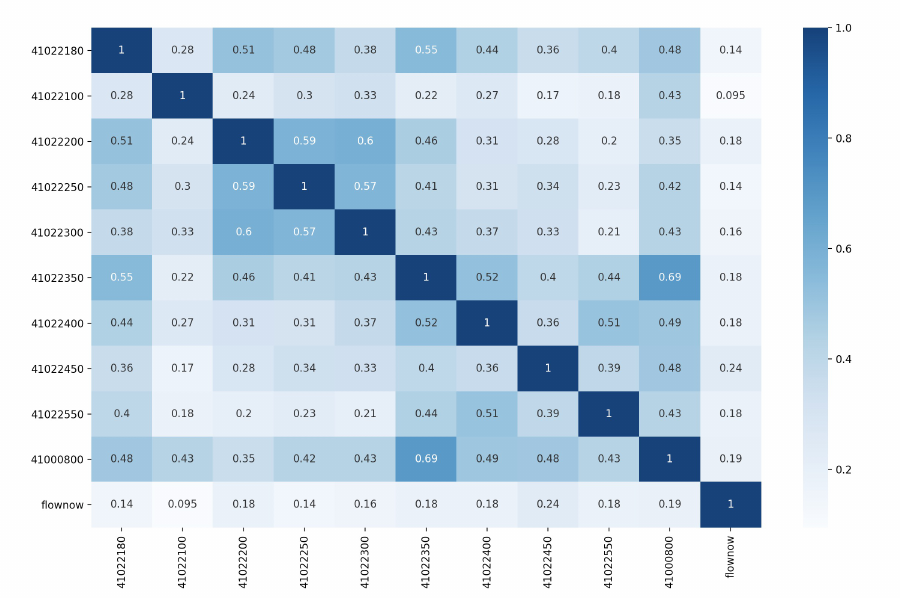
Figure 2. Correlation coefficient matrix of predictors. The figure shows that the correlation of the predictors used in this model is strongly related to the flow of Zhaishang. 41022180 is the code of Luyukou rainfall station, 41022100 is the code of Geshang rainfall station, 41022200 is the code of Tianchidian rainfall station, 41022250 is the code of Baijiatan rainfall station, 41022300 is the code of Chakou rainfall station, 41022350 is Tuncun The code of the rainfall station, 41022400 is the code of Chang’an rainfall station, 41022450 is the code of Caozhuangtou rainfall station, 41022550 is the code of Xingjiashe rainfall station, 41000800 is the code of Zhaishang rainfall station. Flownow is the river flow at the Zhaishang